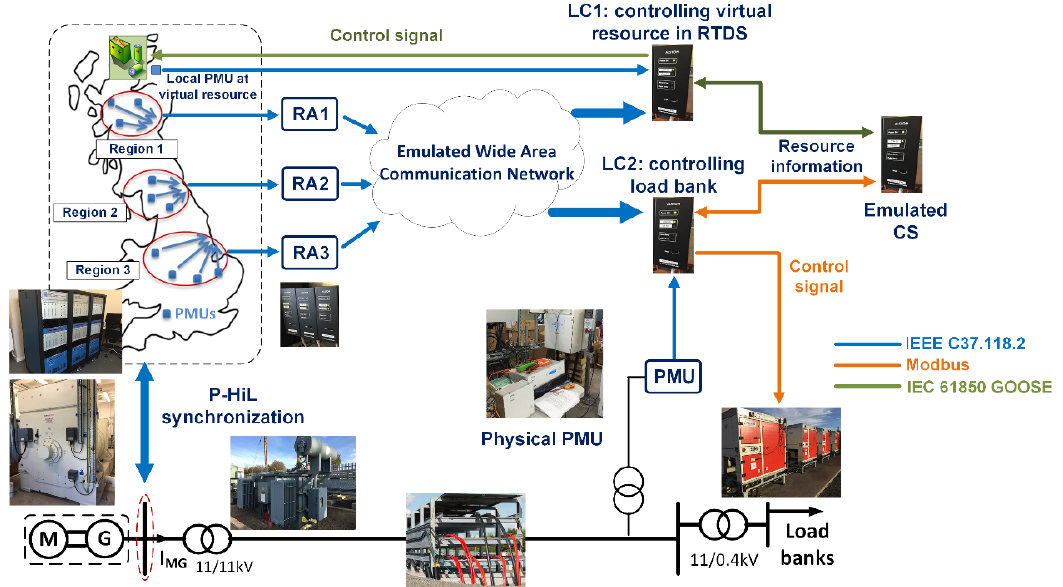
Figure 6. PHIL Experiment realisation for testing the EFCC control scheme performance